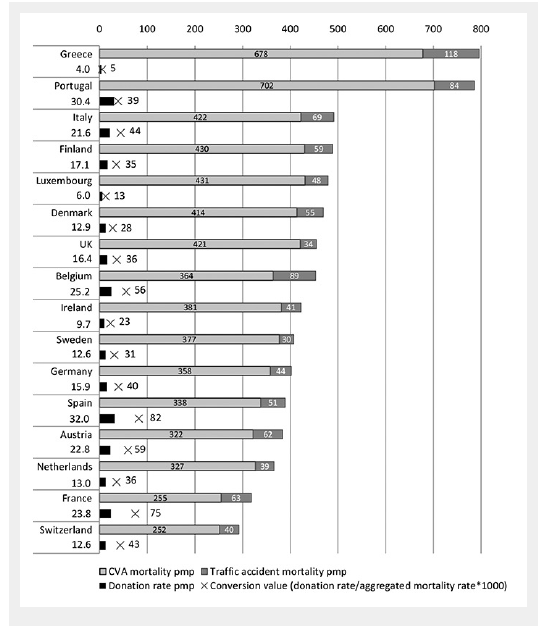
CVA and traffic accident mortality rates vs donation rates in EU 15 countries and Switzerland. Source: Eurostat database, © European Union, 1995–2012; the International Registry in Organ Donation and Transplantation (IRODaT). pmp = per million of